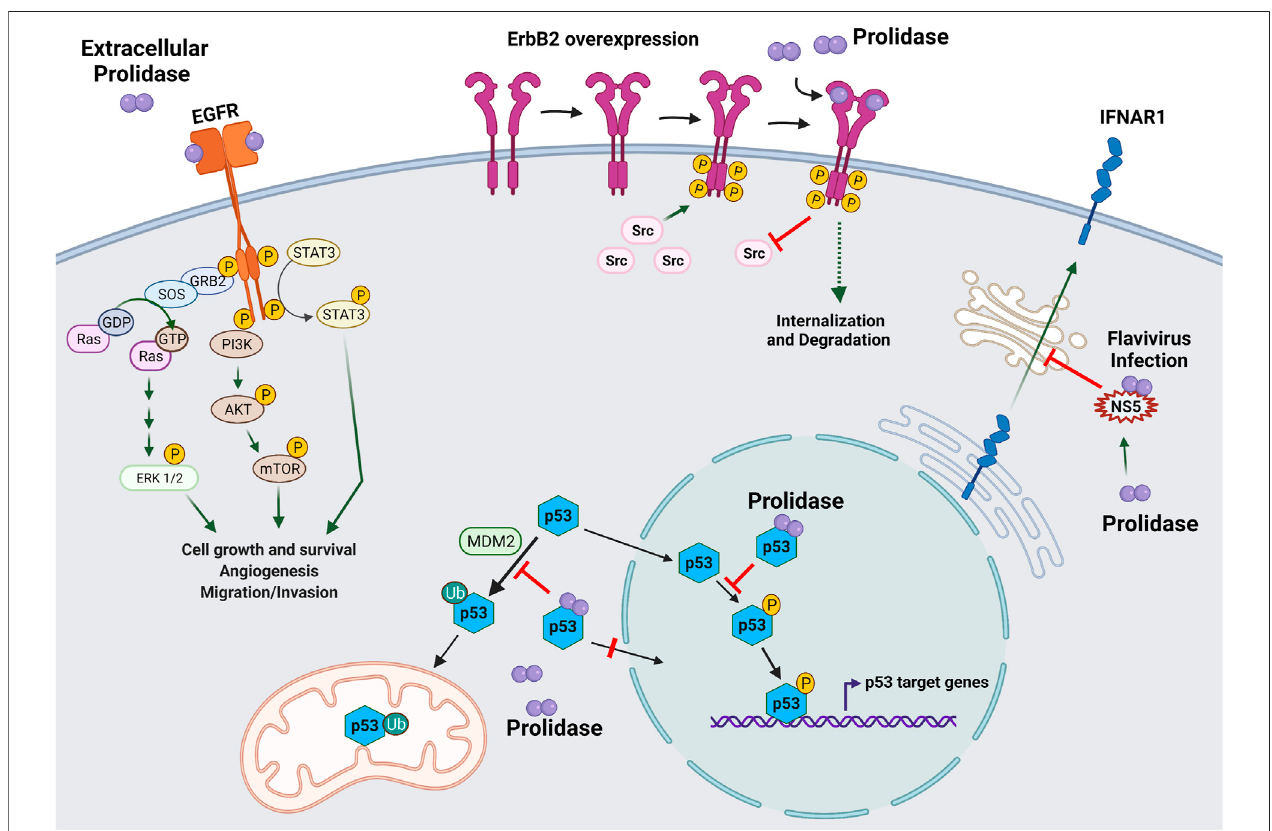
FIGURE4| Enzymeactivityindependentroleofprolidaseincellularregulation.Anovelroleofprolidaseasabiologicalregulatoryproteinindependentofitscatalytic activity has recently emerged. Prolidase was demonstrated to function as a ligand for epidermal growth factor receptor (EGFR/ErbB2) and HER2/ErbB2 receptor. Binding of prolidase extracellularly to EGFR receptor stimulated downstream pathways important in cell proliferation and growth such as extracellular signal-regulated kinase (ERK)1/2, phosphoinositide 3-kinase (PI3K), protein kinase B (Akt), mammalian target of rapamycin (mTOR), and signal transducer and activator of transcription 3 (STAT3). Likewise, prolidase was shown to bind overexpressed HER2/ErbB2 receptor and inhibit downstream signaling via disruption of its association with Src causing internalization and degradation. Prolidase, independent of its catalytic activity was demonstrated to regulate p53 tumor suppressor protein via direct binding. A dual mechanism involving inhibition ofp53 phosphorylation and disruption ofits interaction with MDM2resulted in sequestration ofp53 in the cytosol thereby preventing both transcription-dependent and transcription-independent activities of p53. Prolidase plays a novel role as a regulator of type I interferon (IFN-I) immune responseduring fl avivirusinfection.Itisessentialformaturationandtraf fi ckingofIFN-Ireceptor(IFNAR1).Duringinfection,thenonstructuralprotein5(NS5)producedby fl aviviruses was shown to bind prolidase compromising IFN-1